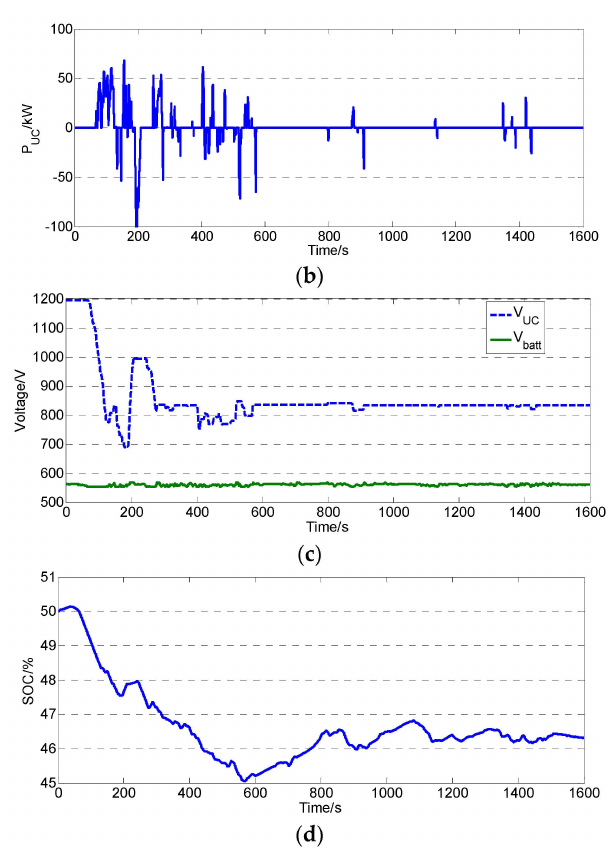
Figure 13. Simulation results for HESS with a logic threshold power management strategy: ( a ) Battery bank power; ( b ) UC bank power; ( c ) Voltage of the battery and UC bank; ( d ) SOC of the battery